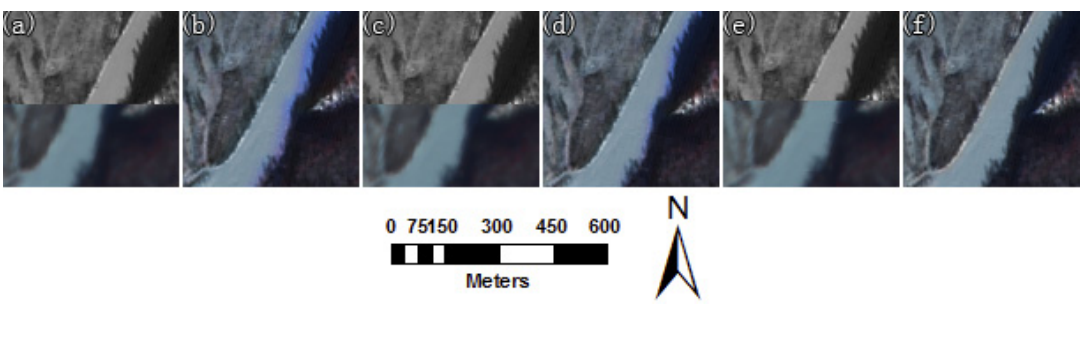
Figure 10. Registration and fusion results of Dataset 1 using ENVI methods. ( a ) shows the swipe effect of registered images through affine transformation method, ( b ) shows the fusion results. ( c , d ) show the result through quadratic polynomial method, ( e , f ) show the result through triangulation